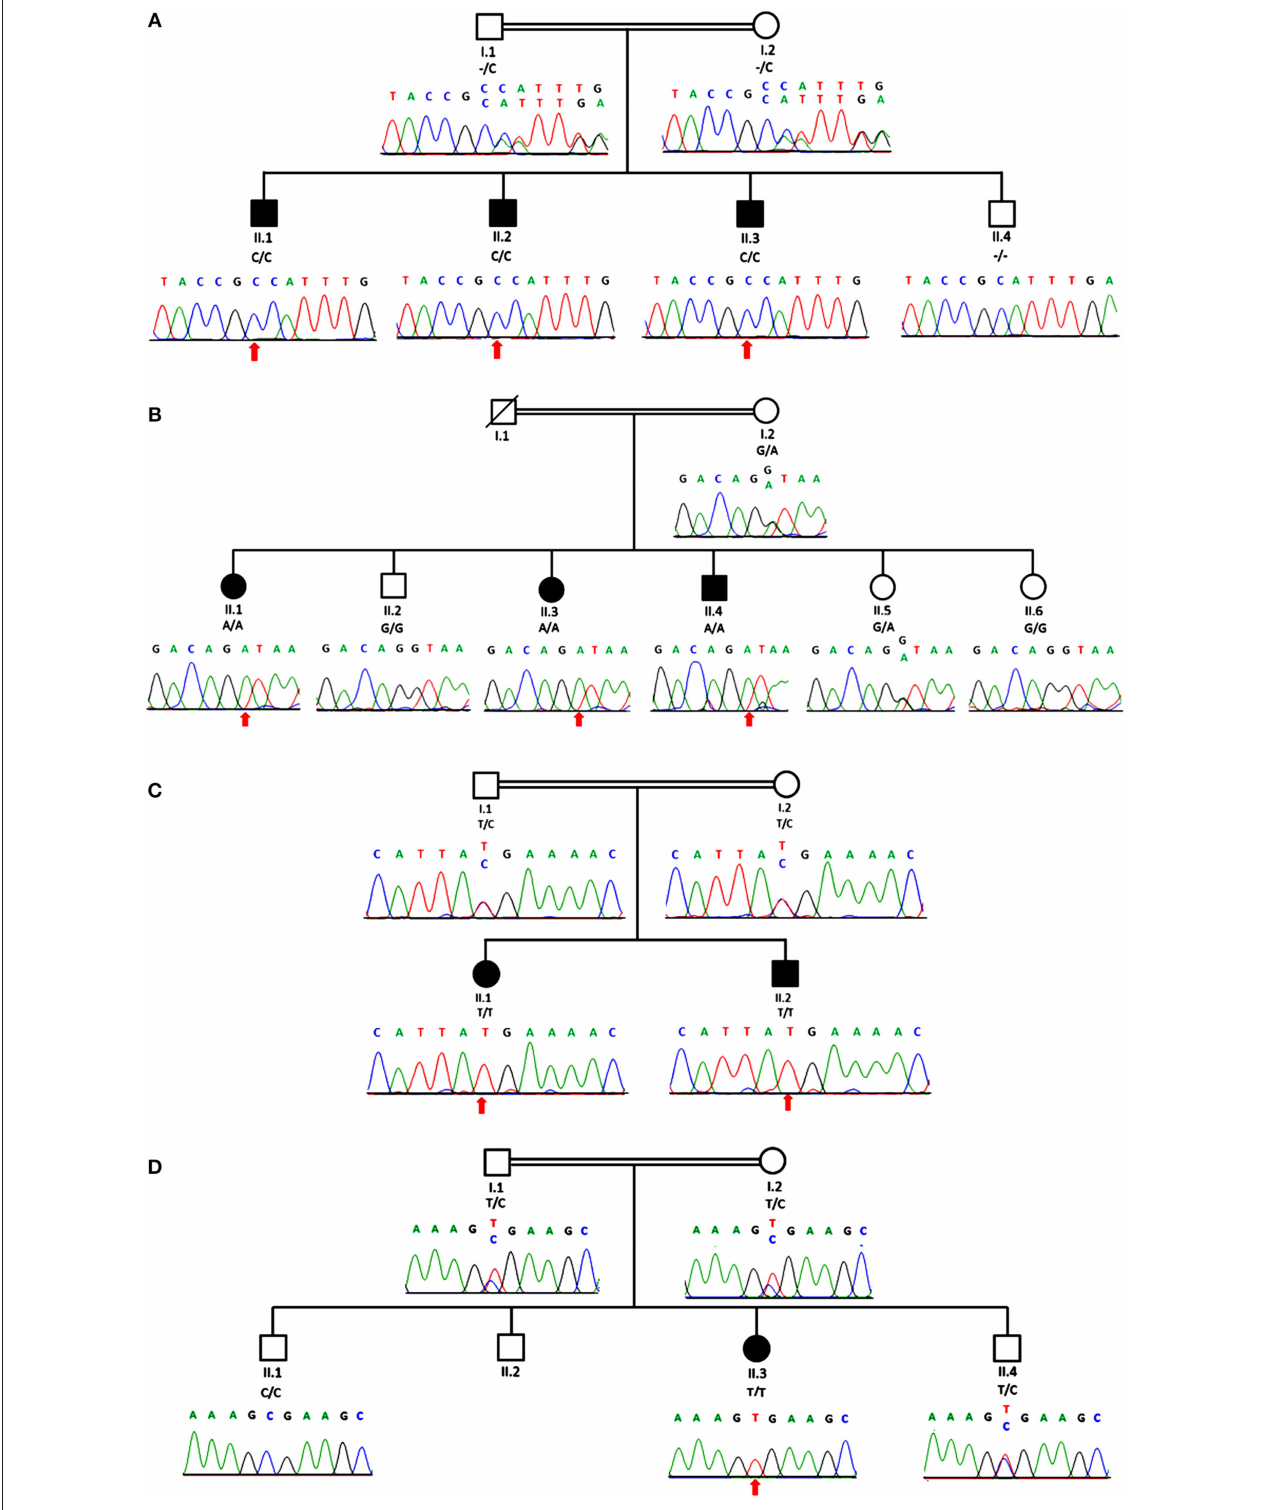
FIGURE 2 | Genomic analysis revealed an individual mutation in MTMR2 gene. The genealogy of the family and the MTMR2 electropherograms show the same novel homozygous c.1490dupC; p.Phe498IlefsTer2 mutation identified in all three siblings in family 1 (A) and a homozygous c.1479 + 1G > A splice site mutation in family 2 (B) and in family 3 (C) a homozygous c.1090C > T; p.Arg364Ter stop mutation and in family 4 (D) a homozygous c.883C > T; p.Arg295Ter mutation in the MTMR2 gene was revealed. Parents were heterozygous for the same mutation as their children in all three families.